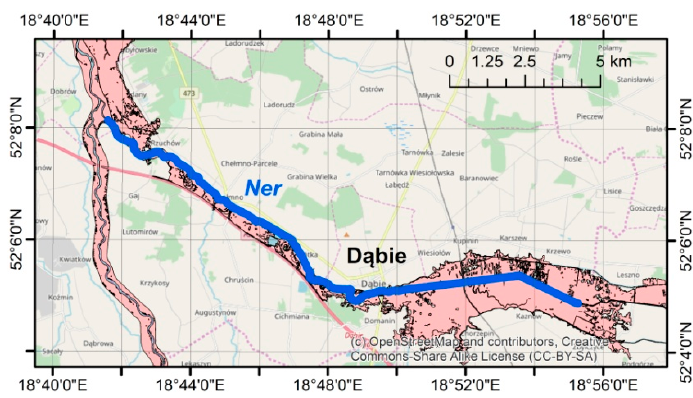
Figure 2. Map presenting the second study areas—the reach of the Ner river.